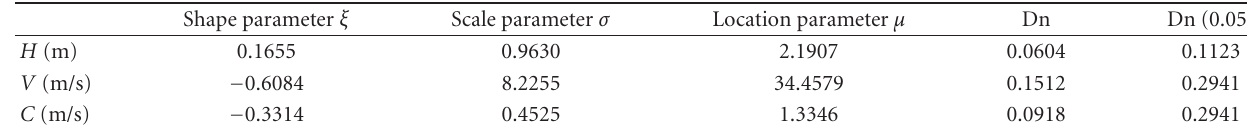
Table 9: Parameters of variables.